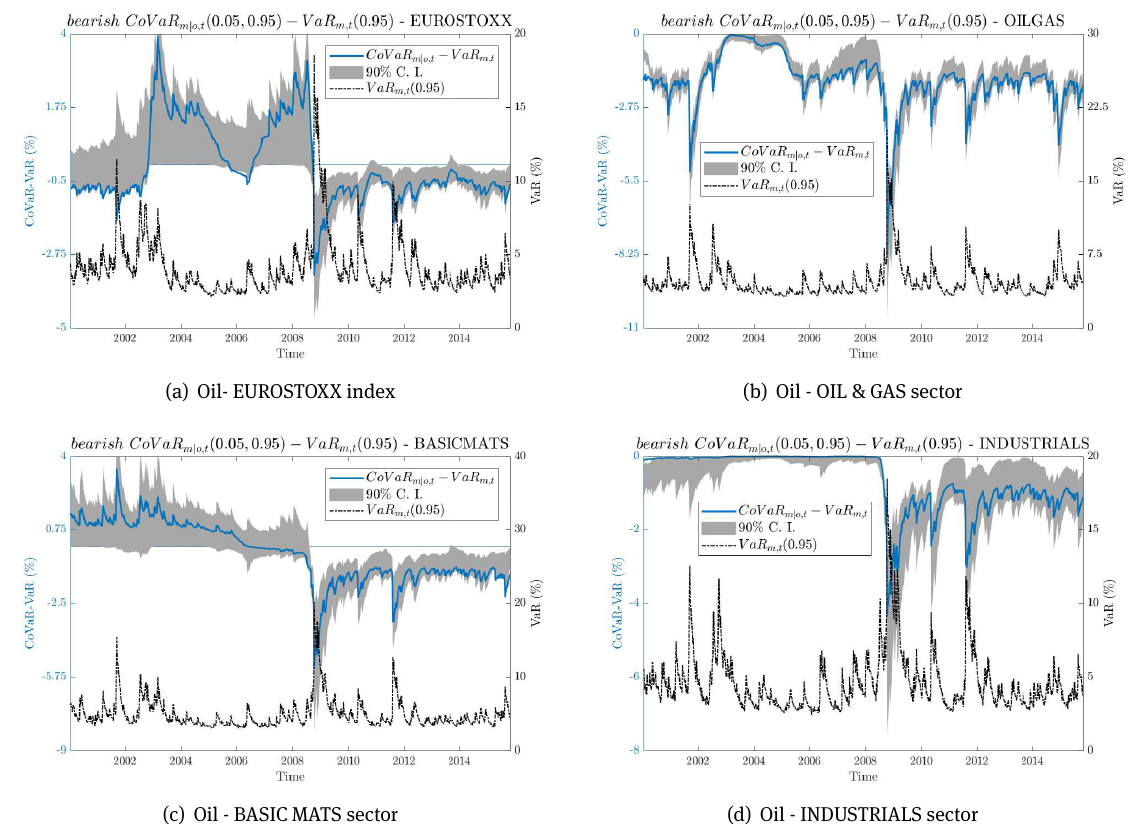
Left axis shows the difference in percentage between the CoVaR (0.05, 0.95) of the returns for a certain sector under a m , t extreme downward movement in oil prices, i.e. below its 5-th quantile, and its unconditional VaR (0.95). Solid blue line m , t shows this difference given the best copula mixture according to Table 6. Grey area indicates the 90% confidence interval of the difference between CoVaR (0.05, 0.95) and VaR (0.95) following a Monte Carlo technique explained in Appendix C. The m , t m | o , t right axes shows the value of the VaR (0.95) in percentage. The dash-dotted black line indicate the VaR level over m , t